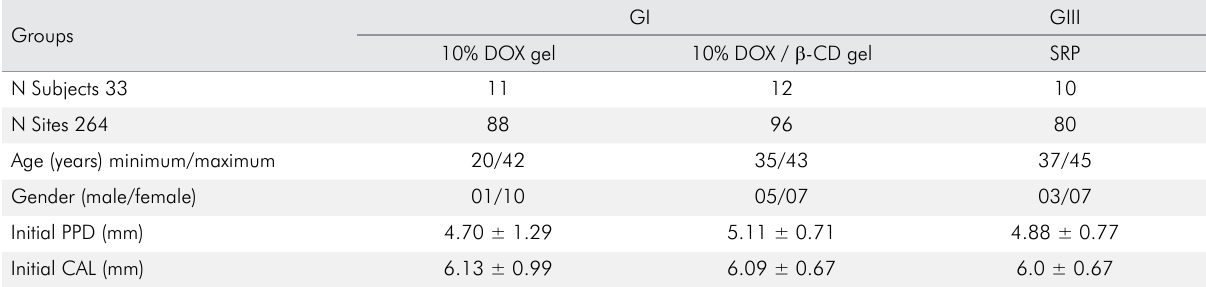
Table 1. Epidemiological characteristics of the patients and mean of the initial PPD and CAL according with protocol analysis. Groups